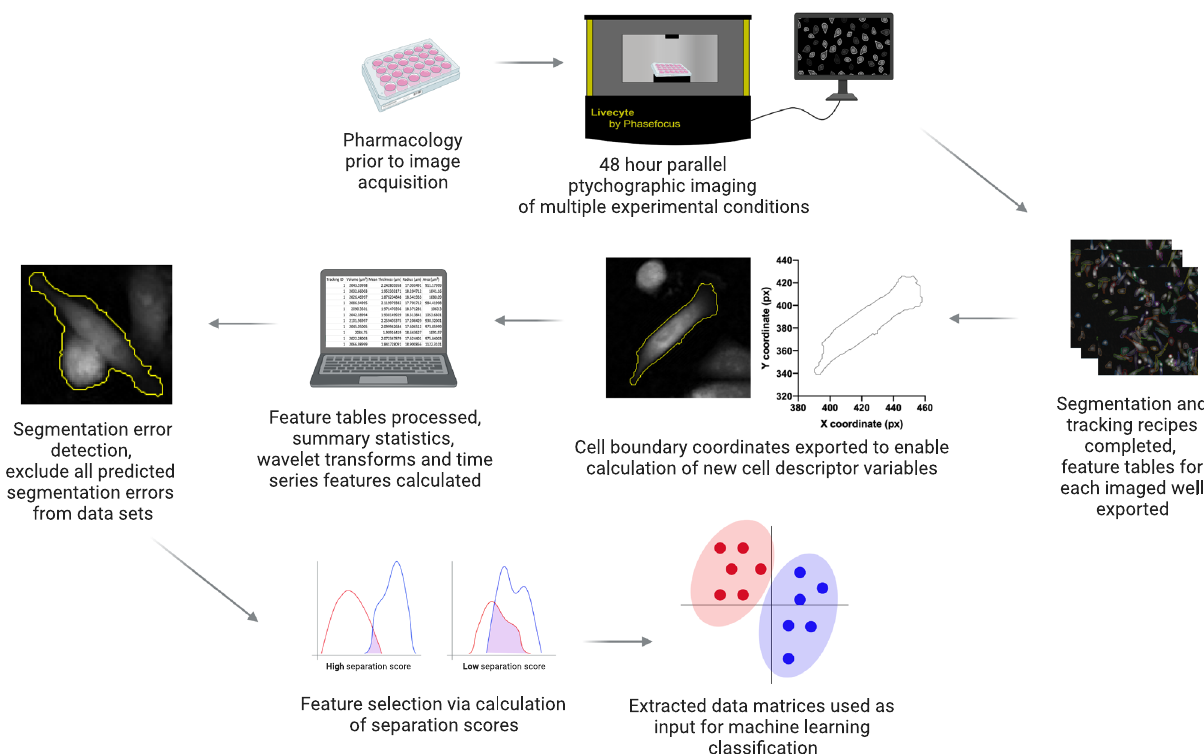
Fig. 1 | Summary of the CellPhe toolkit. Following time-lapse imaging, acquired images are processed and segmentation and tracking recipes implemented. Cell boundary coordinates are exported, features extracted for each tracked cell and the time series summarised by characteristic variables. Predicted segmentation errors are excluded and optimised feature selection performed using a threshold